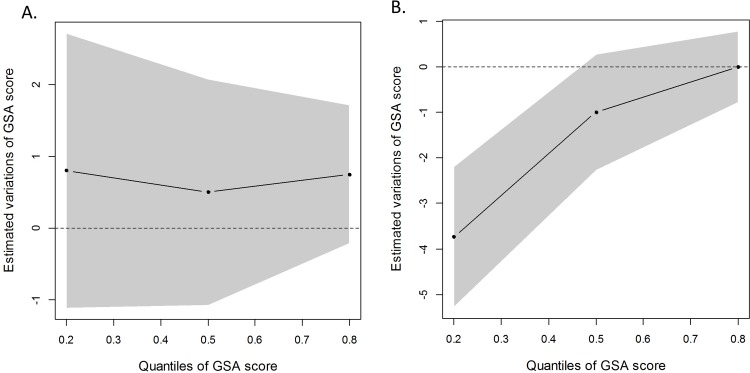
Variations in the “Global School Adaptation” (GSA) score associated with parental separation.(A) Separation that occurred prior to two years of age (included) (n = 104) and (B) separation that occurred between three and five years of age (n = 164), compared to children whose parents who were still living together at five years (n = 2,439). The variations were quantified based on the quantiles of the GSA (i.e. 0.2, 0.5, and 0.8).